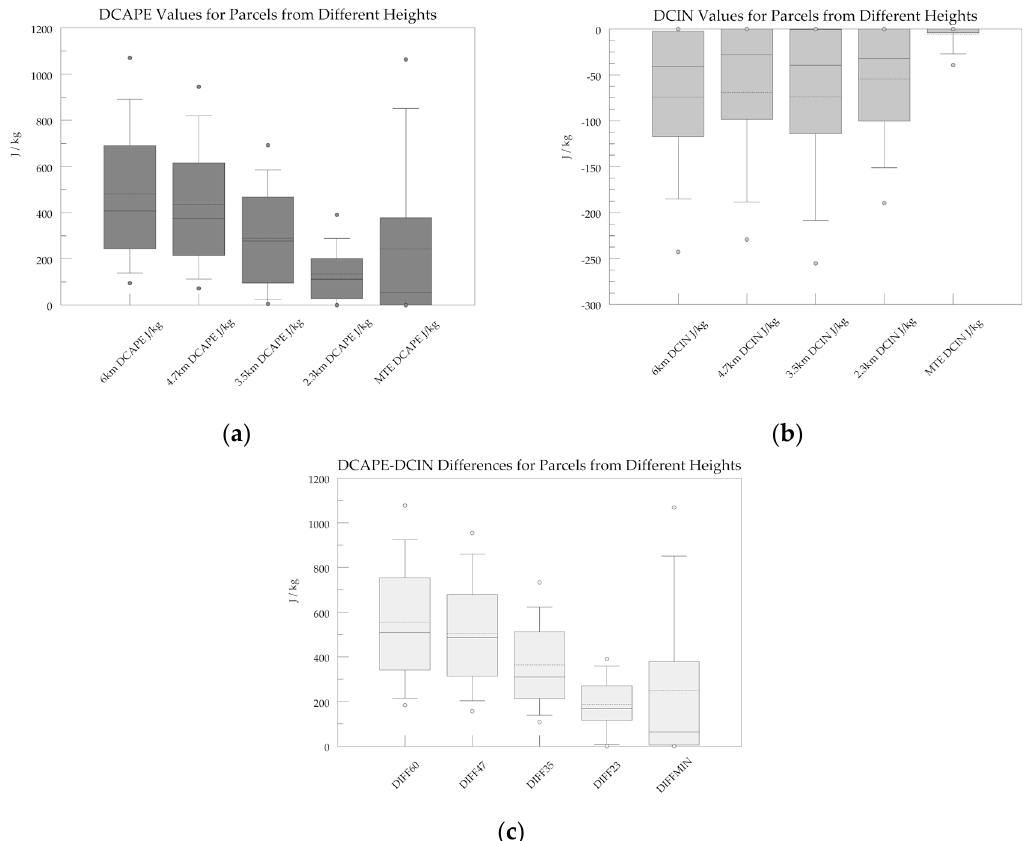
Figure 5. Box-and-whisker plots as in Figure 1, but of the ( a ) DCAPE, ( b ) DCIN, and ( c ) their difference (all in J kg − 1 ) for the 6.0 km, 4.7 km, 3.5 km, 2.3 km AGL levels, along with the values for the minimum θ e (MTE) on the far right of each box-and-whisker collection.